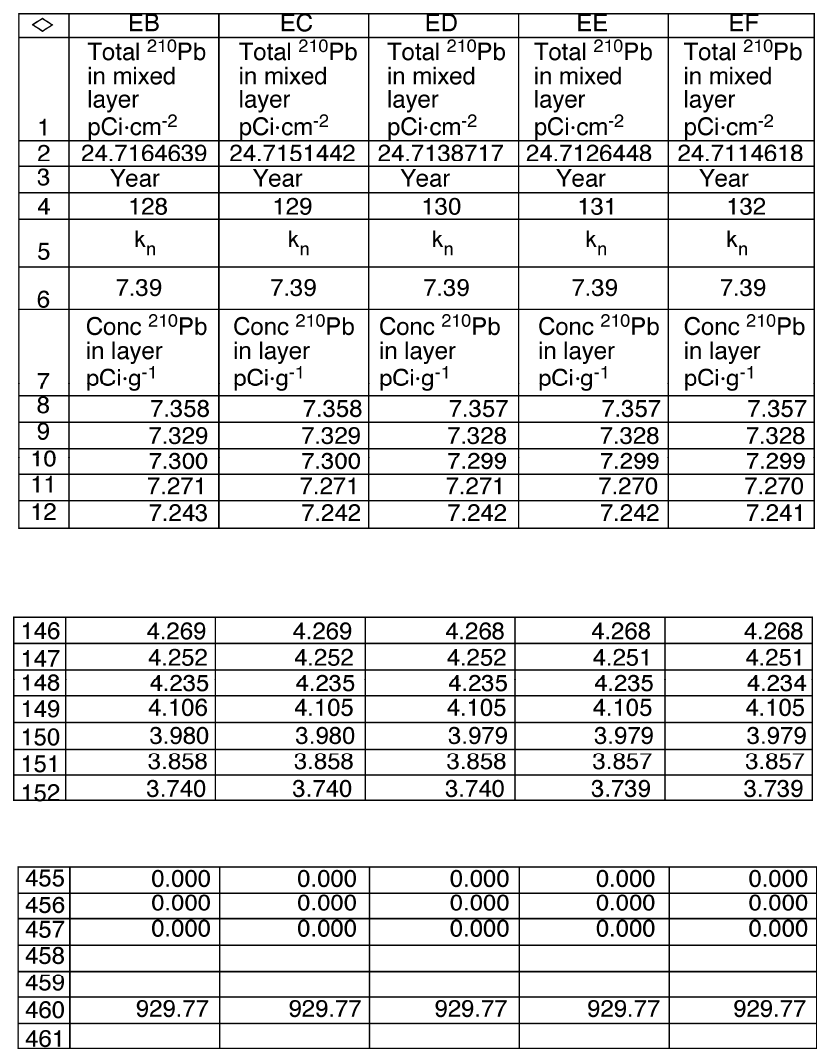
Figure A2. Portions of the Excel spreadsheet for the last 5 columns.